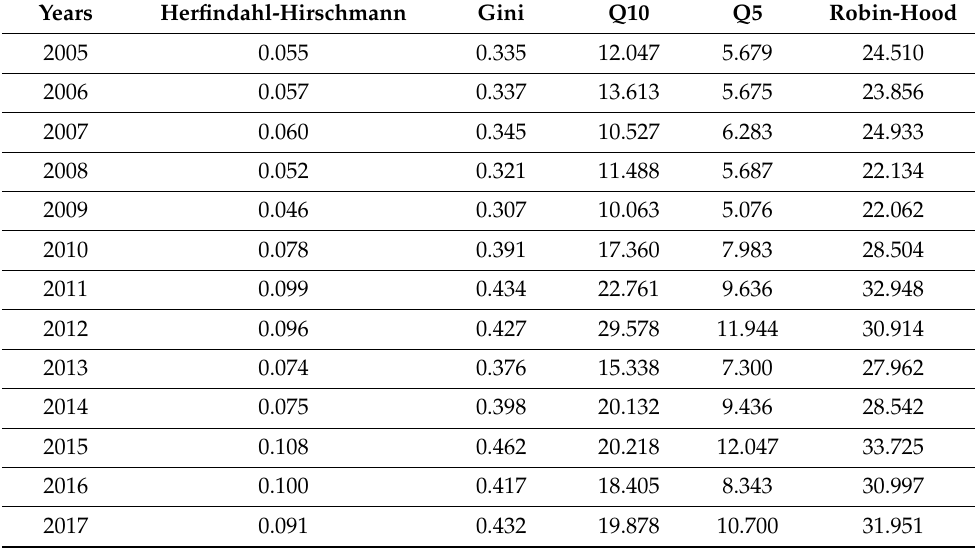
Table 5. Changes in net income inequality distribution indices between 2005 and 2017, households with sports expenditures